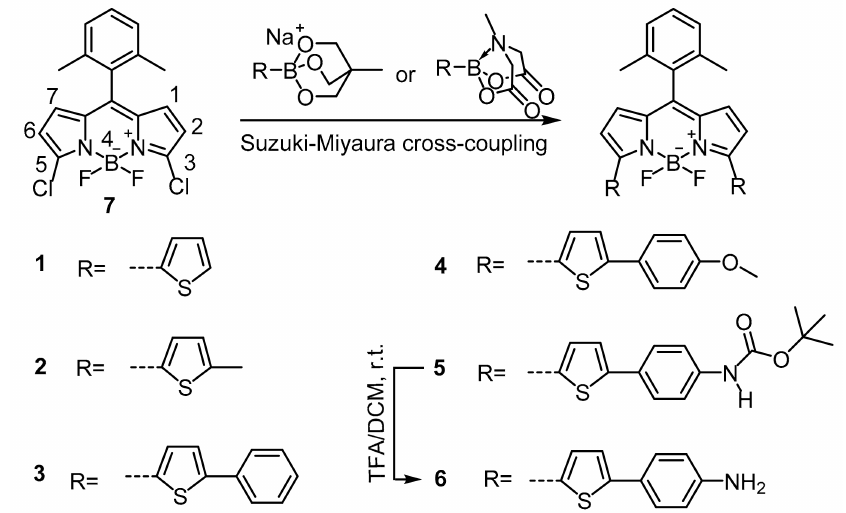
Figure 1. Synthetic scheme to 4,4-difluoro-4-bora-3a,4a-diaza-s-indacene (BODIPY) dyes 1 – 6 . TFA = trifluoroacetic